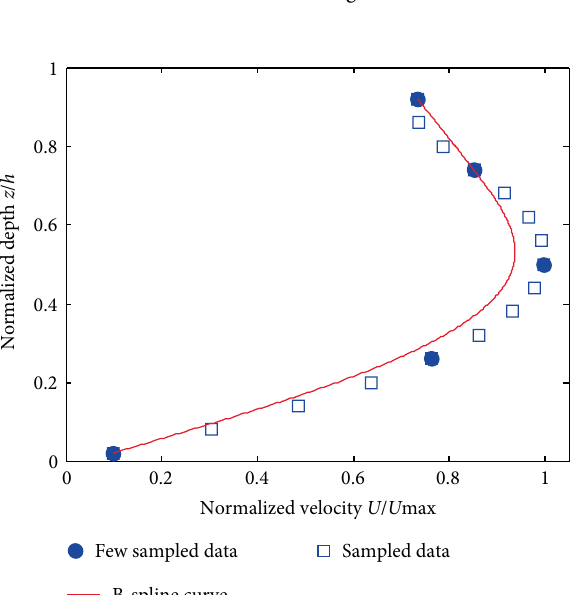
Figure 2: Initial fitting curve.